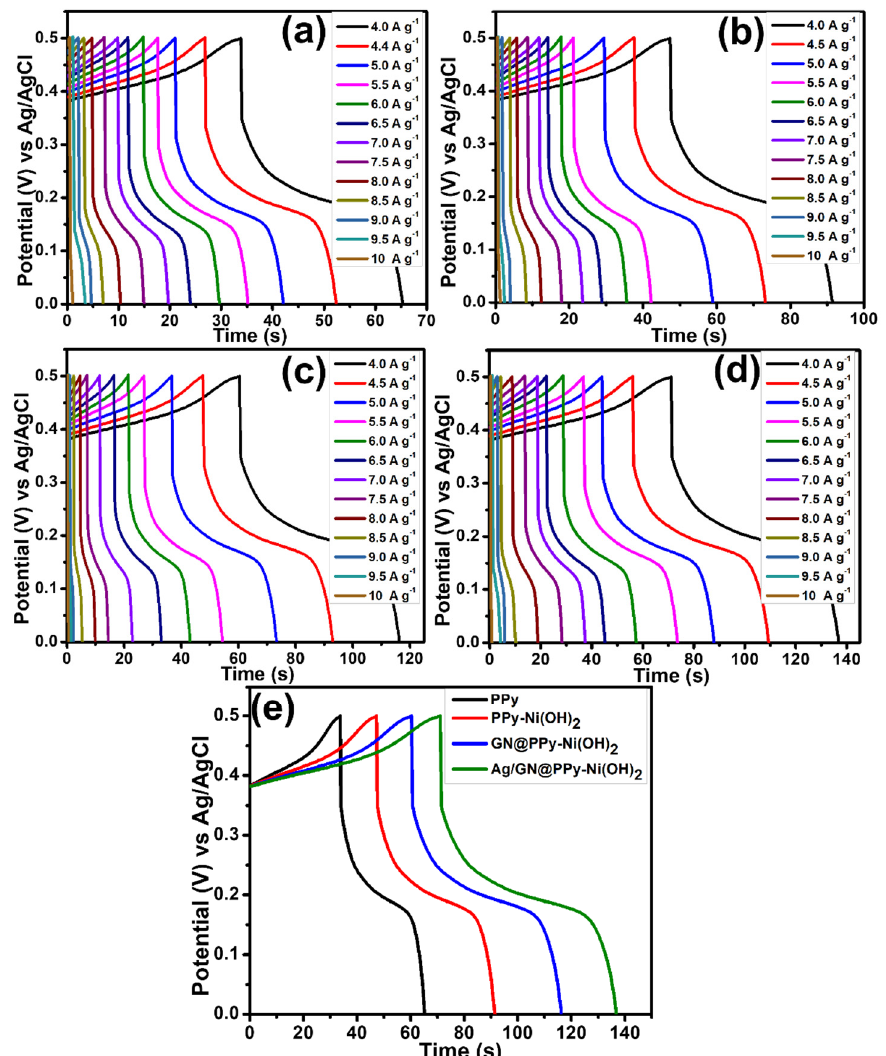
Figure 6. Discharge curves at different current densities: ( a ) PPy, ( b ) PPy–Ni(OH) 2 , ( c ) GN@PPy– Ni(OH) 2 and ( d ) Ag/GN@PPy–Ni(OH) 2 ; and ( e ) comparison of discharge curves of PPy, PPy– Ni(OH) 2 , GN@PPy–Ni(OH) 2 and ( d ) Ag/GN@PPy–Ni(OH) 2 at a current density of 4.0 A g − 1